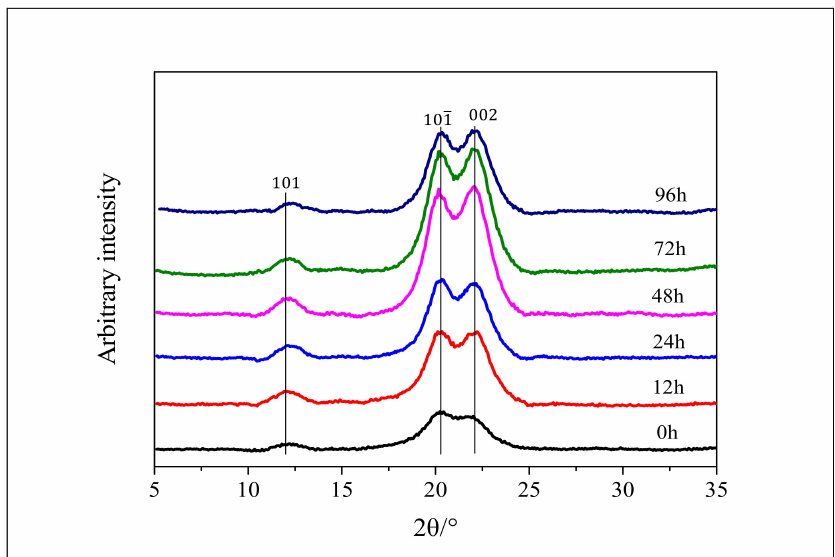
Figure 7. The XRD pattern of α -cellulose after enzymatic hydrolysis.